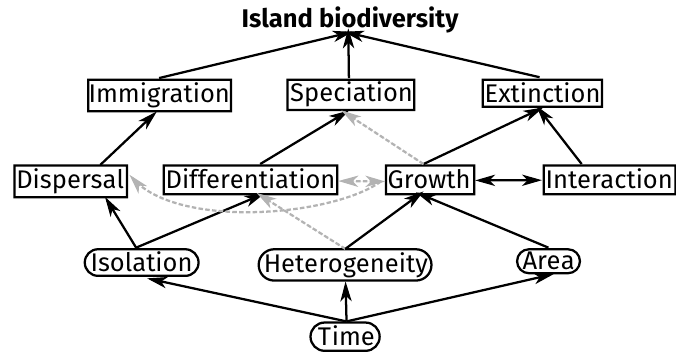
Figure 4. Summary of typical processes and drivers affecting island biodiversity implemented in the models with their assumed causal relationships (Table 1, columns “processes”, “focal level”, “agent level”, “investigated patterns”). Round and square boxes denote drivers and processes, respectively. The bottom row of processes represents processes usually acting on individual-/population-levels, the top row of processes metacommunity-level processes. Black boxes and text mark factors and relationships regularly integrated in models, while grey arrows stand for thus far under- or un-explored relationships. Note that authors may opt to implement models that skip certain organizational levels, for example for investigating the direct effect of isolation on extinction as predicted by the ETIB. Additional relationships not explicitly stated in the chart include rescue-effects [53] between isolation and extinction and target effects [54] from area to immigration. For clarity, these kinds of relationships have been excluded from the graphic. Furthermore, “growth” combines both birth and death processes, while “interactions” include positive, neutral and negative interactions, for example competition or trophic interactions, and “differentiation” encompasses micro-evolutionary processes, such as mutation and gene flow. For a more complete overview of processes, patterns and organizational levels, the reader may refer to Figure